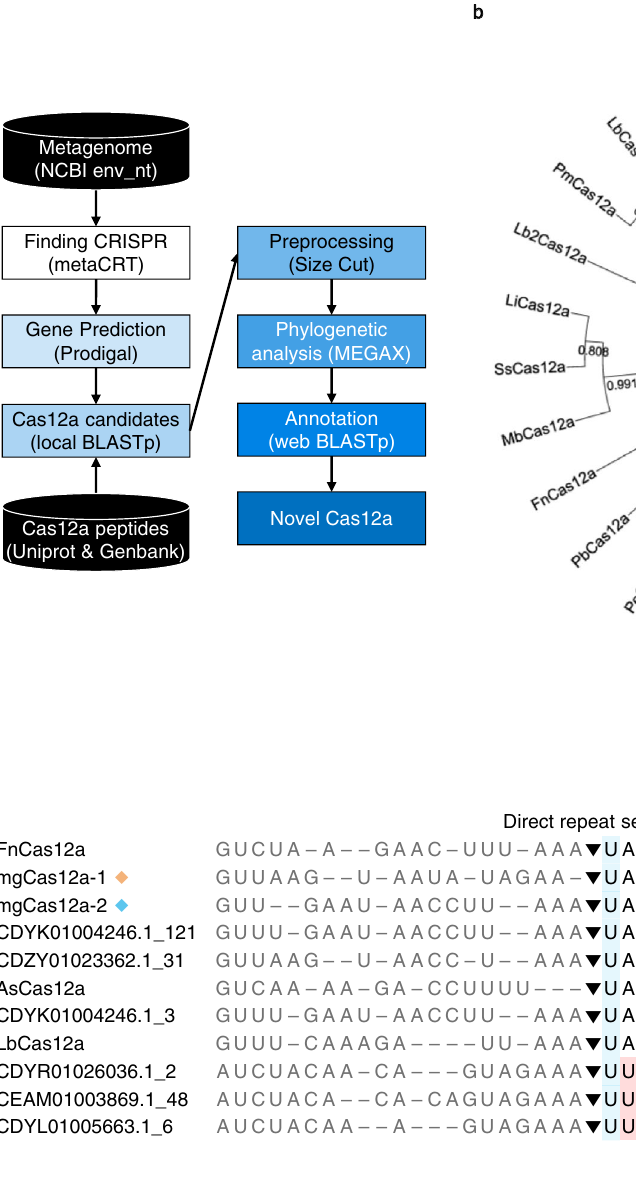
Figure 1. Discovery of Cas12a candidates from the human gut microbiome. ( a ) Pipeline used to search for and classify new putative Cas12a proteins. CRISPR arrays were identified from GenBank metagenome data; putative Cas proteins were then sorted based on amino acid length and their evolutionary relationships with 16 previously characterized Cas12a proteins. ( b ) Phylogenetic tree of 27 Cas12a variants. The tree consists of 16 previously known Cas12a proteins and 11 Cas12a candidates extracted from the human metagenome. The tree was constructed with iTOL v6; bootstrap values (1000 ×) are displayed at each node. MgCas12a-1 and mgCas12a-2 are highlighted in orange and blue, respectively. ( c ) Alignment of direct repeat sequences associated with 8 novel Cas12a candidates and 3 previously known Cas12a orthologs. The sequences removed during crRNA maturation are shown in gray. MgCas12a-1 and mgCas12a-2 are indicated with orange and blue diamonds, respectively. Black triangle indicates putative cleavage site during crRNA processing. Consensus sequences and mismatching 5 ′ handle sequences are highlighted in blue and pink,